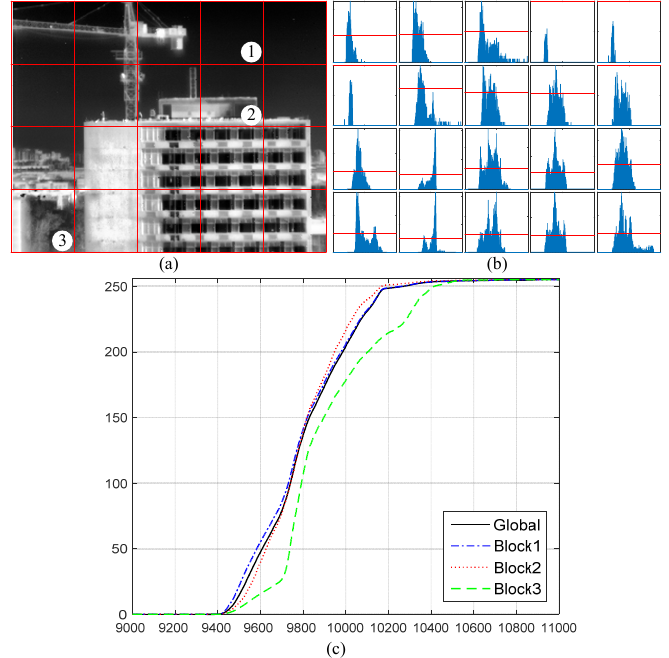
Figure 5. The enhanced result of the given infrared image using the improved CLAHE. ( a ) The enhanced result. ( b ) The neighborhood conditional histogram of each sub-block and the red line is introduced to be a reference value of ten. ( c ) The global mapping function and the local mapping functions of sub-block 1, 2, and 3 in the improved CLAHE. The X-axis range in ( b , c ) are set to be (9000,11,000) for better